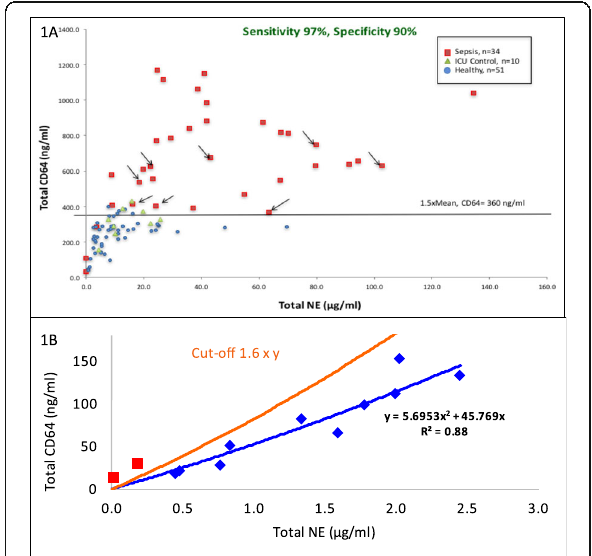
Fig. 1 (abstract P25). CD64 and NE ELISA for whole blood from patients with suspected sepsis (n=34, red squares) or ICU controls (n=9, green triangles) or healthy (n=51), blue circles). (A) Assigned cut-off for total CD64 (1.5 x Mean); 31/34 sepsis patients have levels of CD64 above these cut-offs. Arrows: These eight patients negative by Leuko64 TM flow cytometric assay were positive for Total CD64. (B) Expanded data for samples with levels of total NE <2.5 μ g/ml, including the 2 neutropenic sepsis samples (red) that have elevated levels of CD64 compared to an assigned cut-off of 1.6 x the trendline for healthy